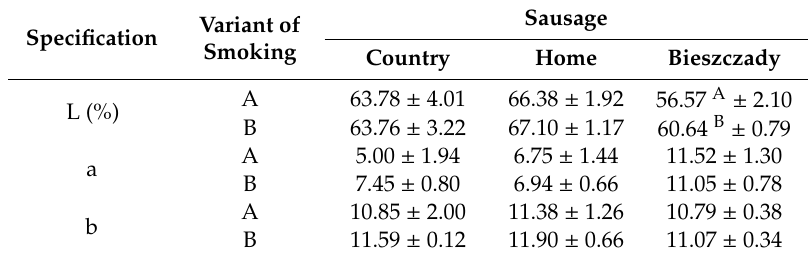
Table 3. Colour parameters of medium-ground sausages (2 samples × 10 batches × 2 variants × 3 types of sausages = 120 sausage samples) ( x ±